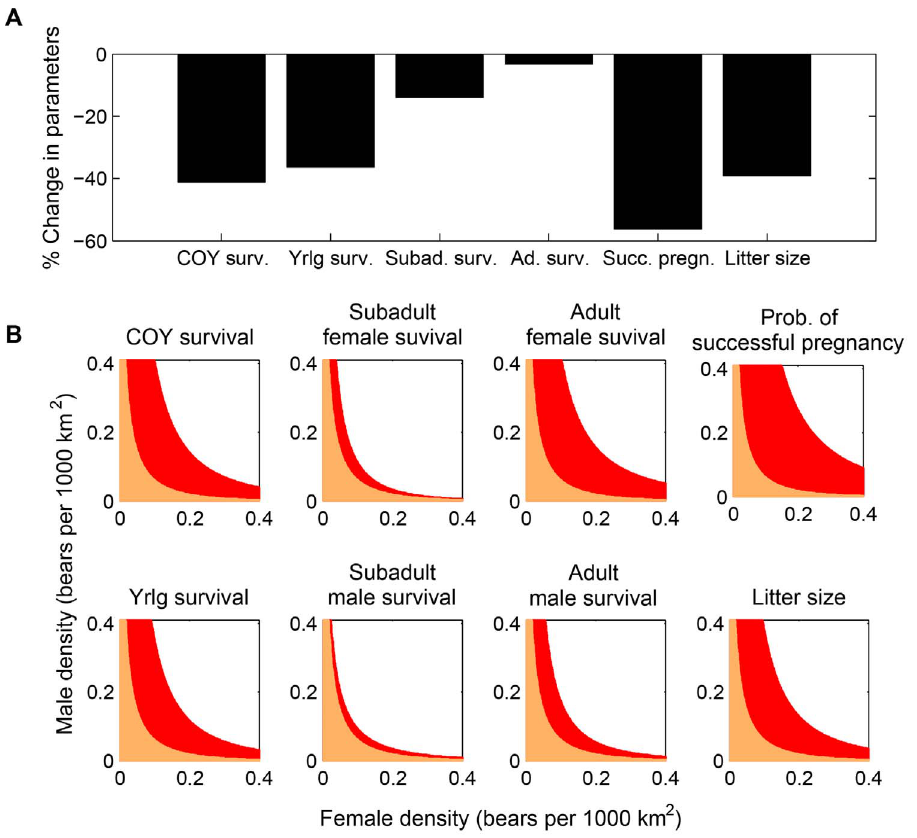
Figure 3. The dependence of the Allee threshold on the parameters of the projection matrix A n . To allow for a common baseline of comparison between these life history parameters, we reduced parameters one at a time such that the stable-stage population growth rate l was reduced by 50% from its baseline (i.e., from l =1.056 to l =1.028). This scaling ensures that the direct effects of each parameter on the Allee threshold are separated from the effects each parameters would have on this threshold via its effects on the population growth rate l . Panel (A) shows the proportional amount by which each parameter needed to be reduced relative to its baseline value to obtain l =1.028. (B) Scenarios marked orange (replotted from Fig. 2) would lead to extirpation both with the baseline parameters and the reduced parameters; scenarios marked red would lead to extirpation with the reduced parameters, but not with the baseline parameters. Each panel considers the ‘‘old’’ population scenario, where all females and males are sexually mature adults (i.e., in stages 4 and 10, cf. Fig. 1) at the beginning of the projection, and no female is accompanied by dependent offspring.